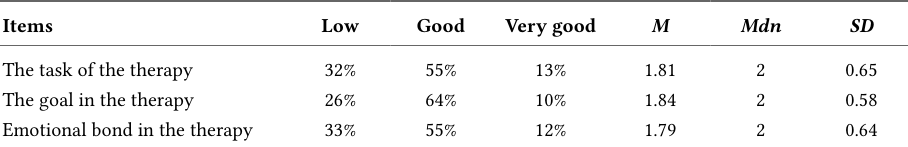
Ratings of Alliance in Association With a Dropout